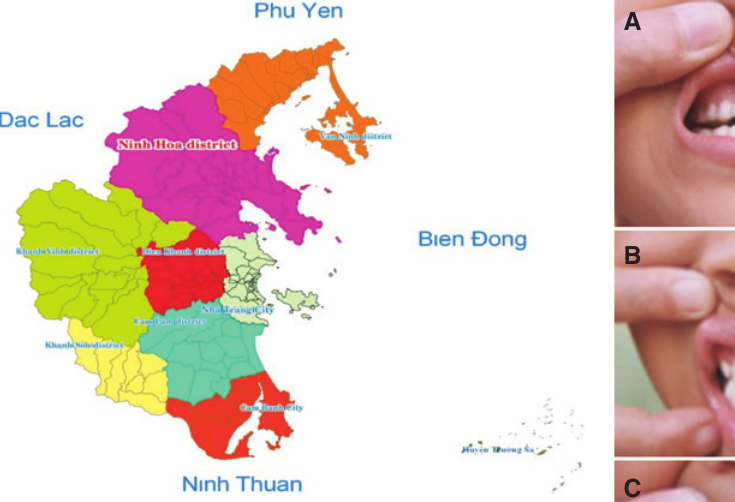
Figure 12: Ninhhoa district